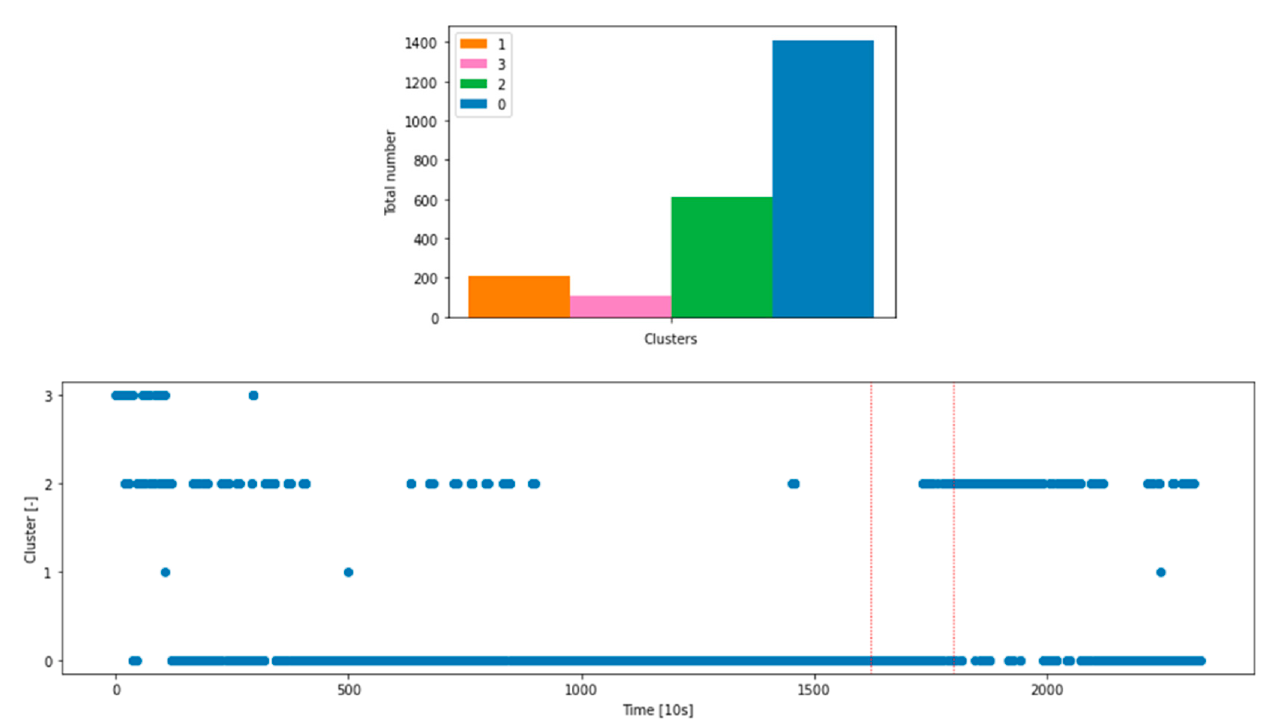
Figure 10. Size of clusters and temporal evolution of cluster predictions using hierarchical clustering with Ward linkage.